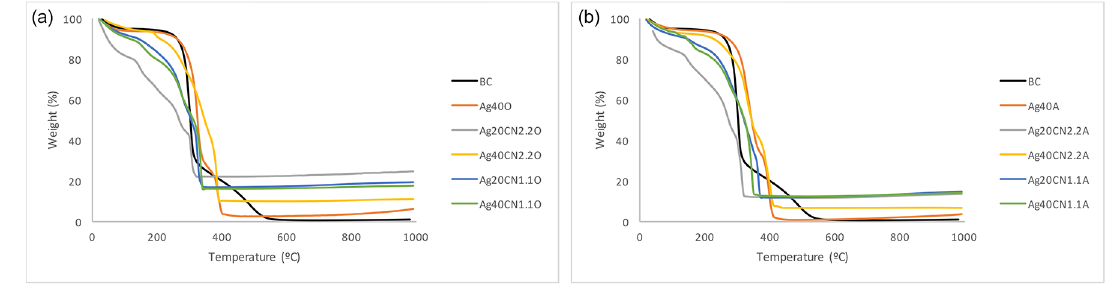
Figure 6. TG curves obtained by thermogravimetric analysis of the BC membranes submitted to different thermal treatments: a) oven and b) autoclave. Table 2. Data extracted from TG curves for all BC membranes submitted to different thermal Sample